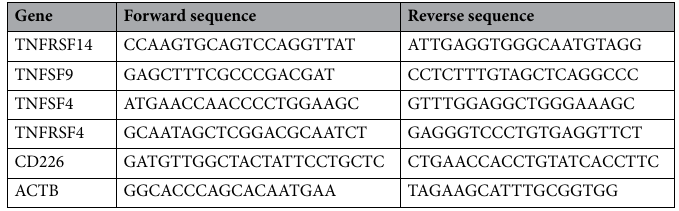
Table 1. The Primer sequences list for